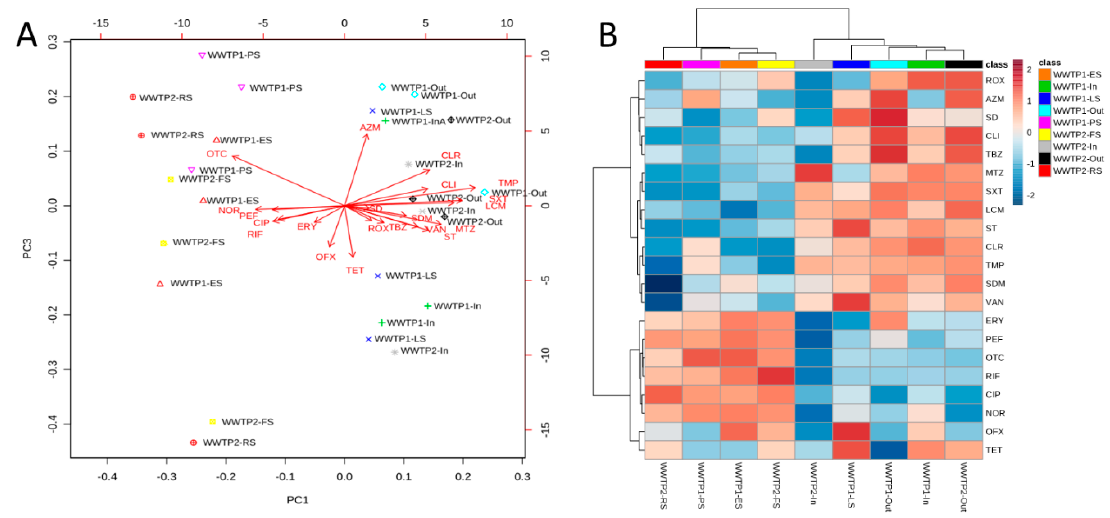
Figure 3. Differences in antimicrobials’ concentrations between the wastewater, sludge samples, and leachate collected from WWTP1 and WWTP2. Principal component analysis (PCA) of the all samples ( A ). Variables of a data matrix are represented as arrows. Visualization of the observed relations on the heat map ( B ). ES, excessive sludge; FS, fermented sludge; In, influent; LS, leachate; Out, effluent; PS, primary sludge; RS, residual sludge.